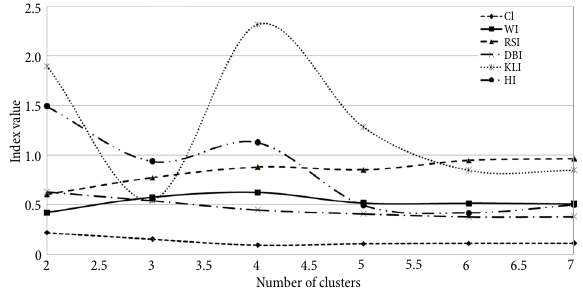
Fig. 3. Validation measures for optimal number of clusters using AP